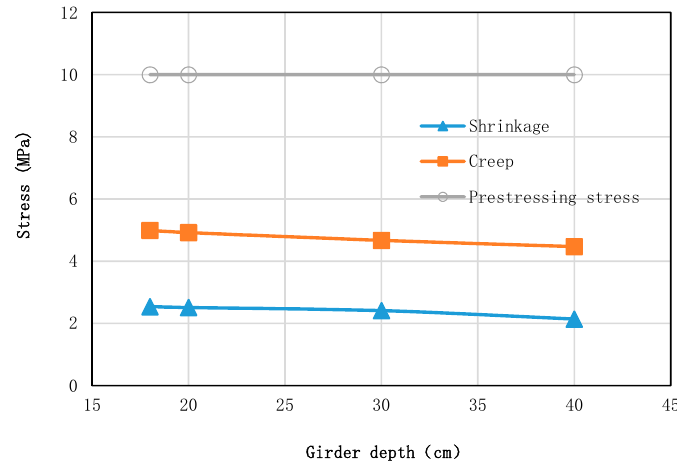
Figure 9. Stress variation in the concrete deck in the hogging region due to different effects for different girder